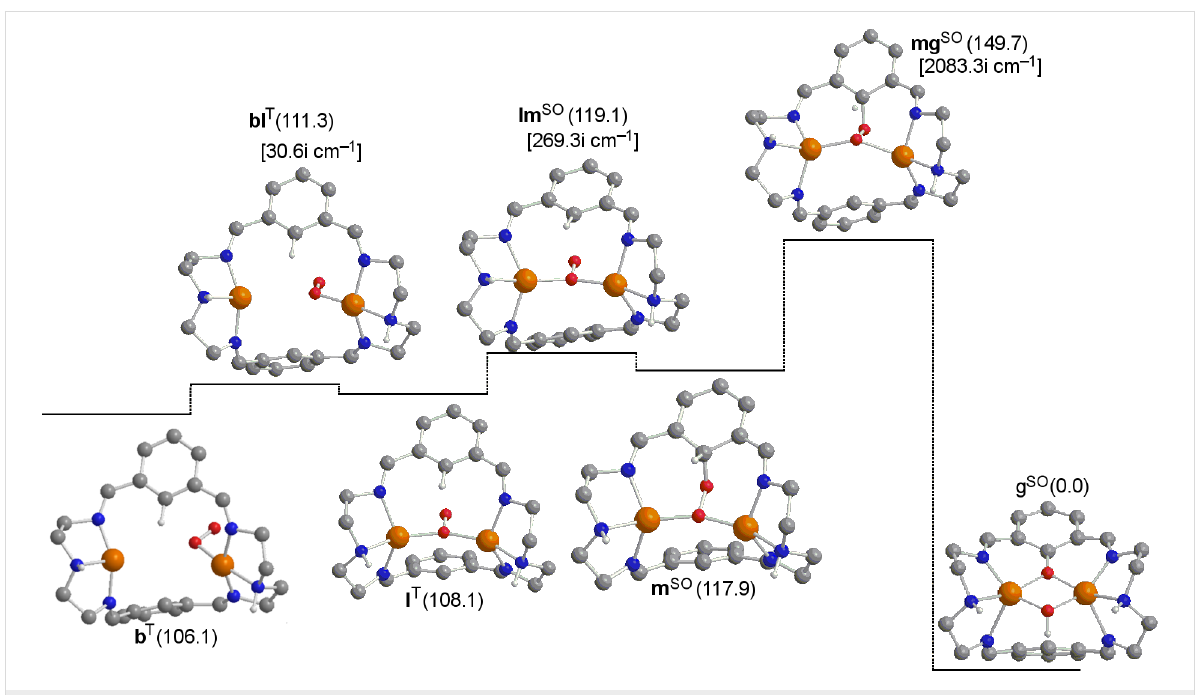
Figure 6: Computed structures for a potential alternative pathway b → g of the σ * mechanism (some H atoms omitted for clarity). Gibbs energies rela- tive to product g (in kcal·mol − 1 ) in solution are given in parentheses. Calculated imaginary frequencies for transition structures are given in brackets. Superindexes SO (open-shell singlet) and T (triplet) refer to the multiplicity of the ground